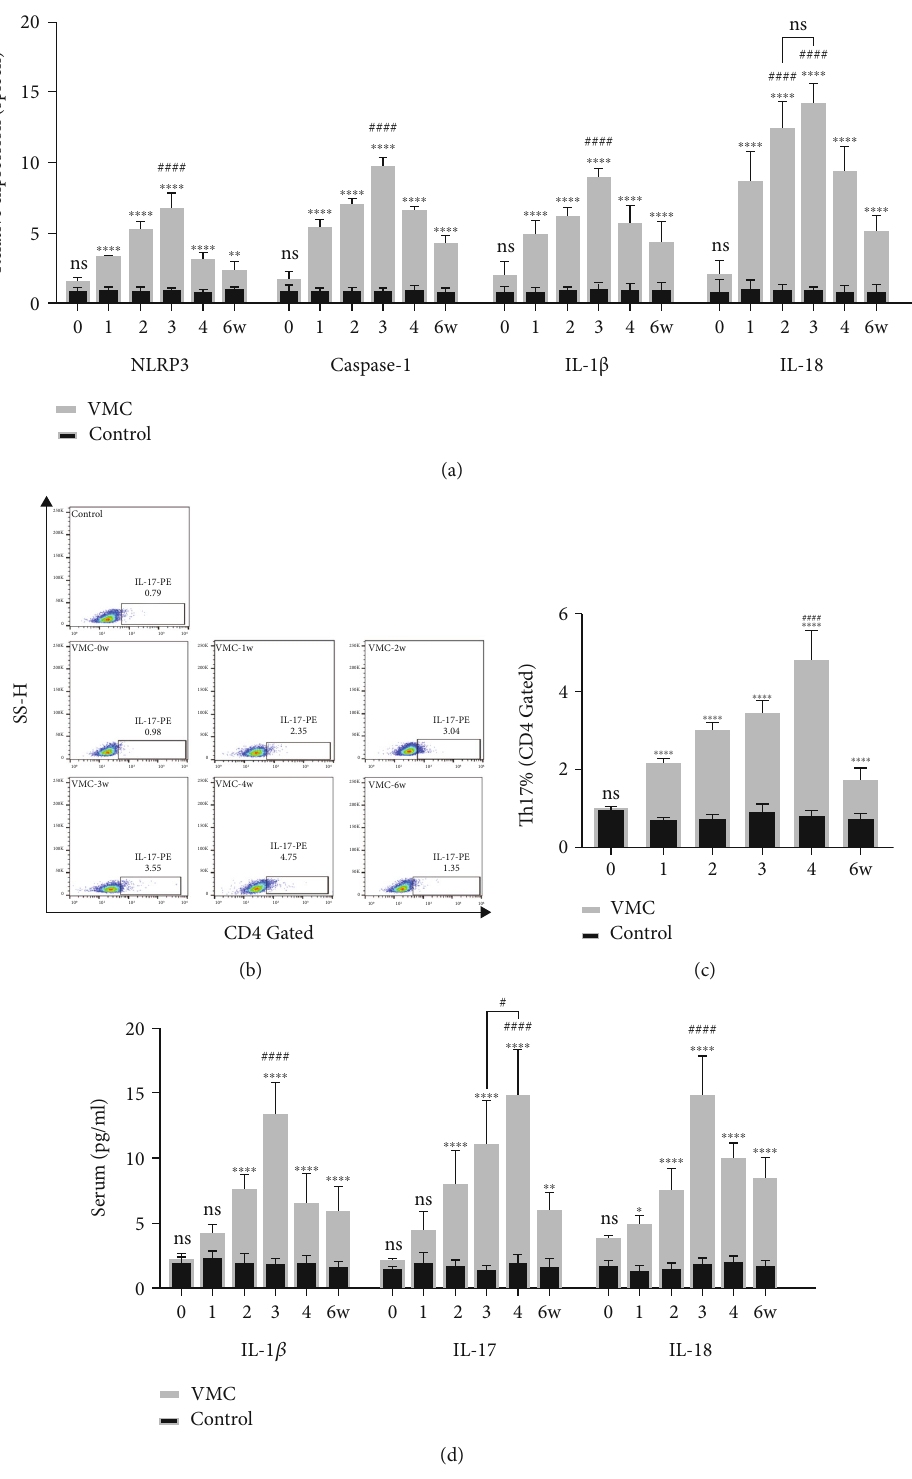
Figure 3: The change pattern of NLRP3-related molecules in the spleen and serum in VMC process. (a) Relative mRNA expression of NLRP3, Caspase-1, IL-1 β , and IL-18 in spleen tissues during VMC process. (b) The proportion of Th17 cells in spleen samples during VMC process. (c) Statistical histogram of Th17 cell proportion calculation. (d) Protein level of IL-1 β , IL-17, and IL-18 in serum during VMC process. Statistical description: ns, ∗ , ∗∗ , and ∗∗∗∗ stand for no statistically signi fi cant di ff erence, P < 0 : 05 , P < 0 : 01 , and P < 0 : 0001 , respectively, for VMC group versus control group at di ff erent time points. #, ###, and #### mean P < 0 : 05 , P < 0 : 001 , and P < 0 : 0001 for the marked VMC group versus other VMC